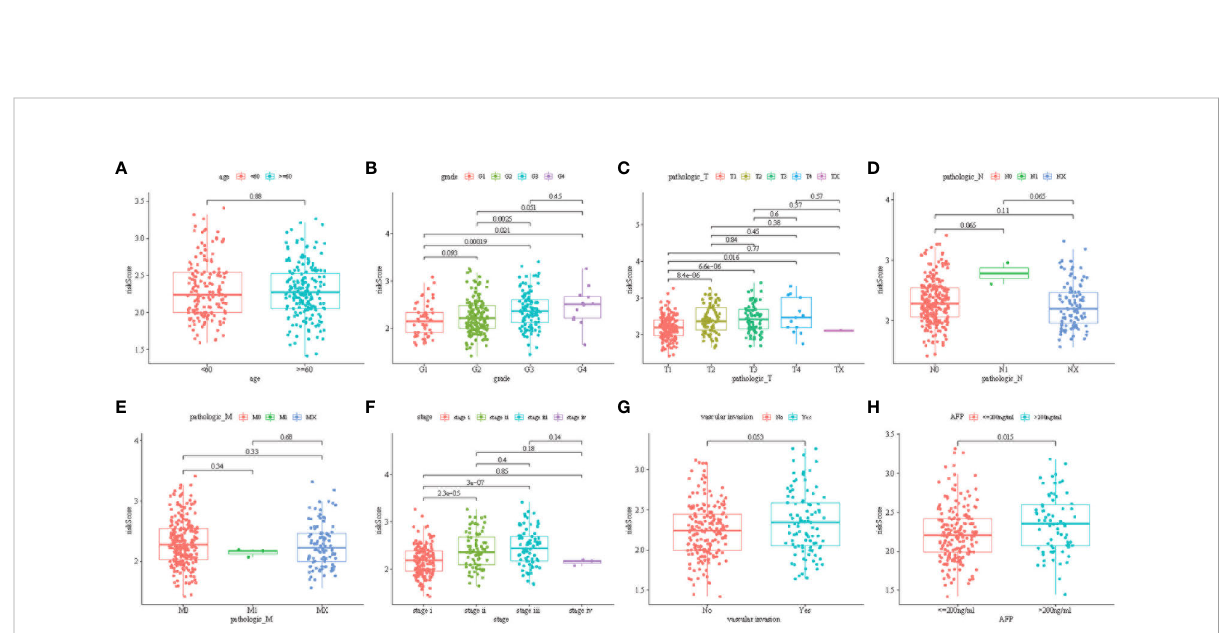
FIGURE 5 Distribution of risk scores among age group (A) ; tumor grade (B) ; tumor pathologies T (C) , N (D) , and M (E) ; cancer stage group (F) ; vascular invasion (G) ; and AFP group (H) (P <